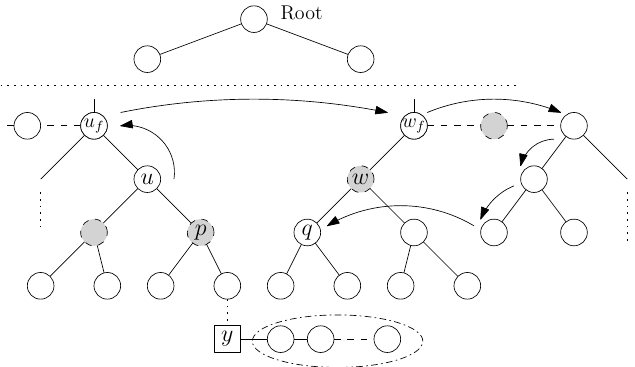
Figure 3. Example of vertical search between u and unreachable w